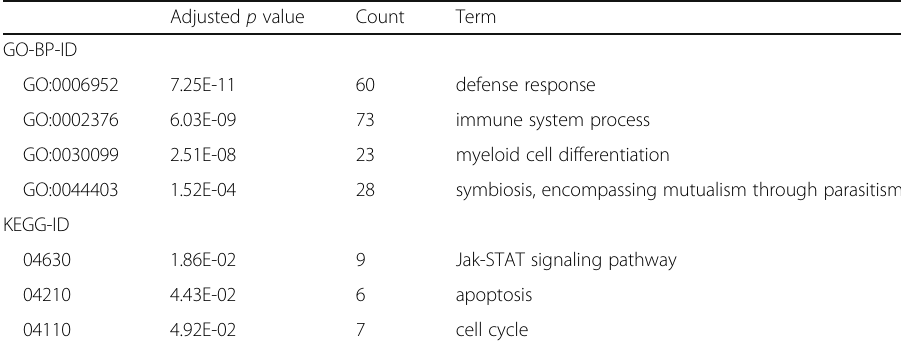
Table 3 GO biological processes and KEGG pathways for significantly changed genes in comparison 1